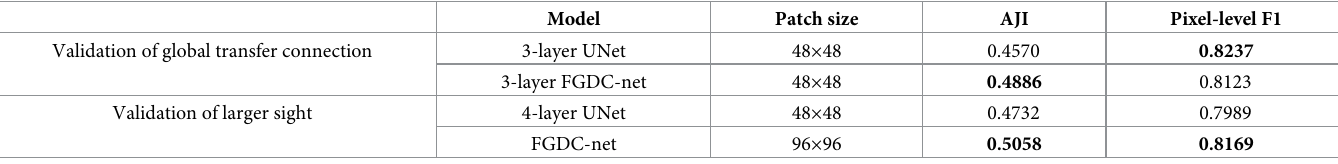
Table 4. Ablation experimental results of multiple network